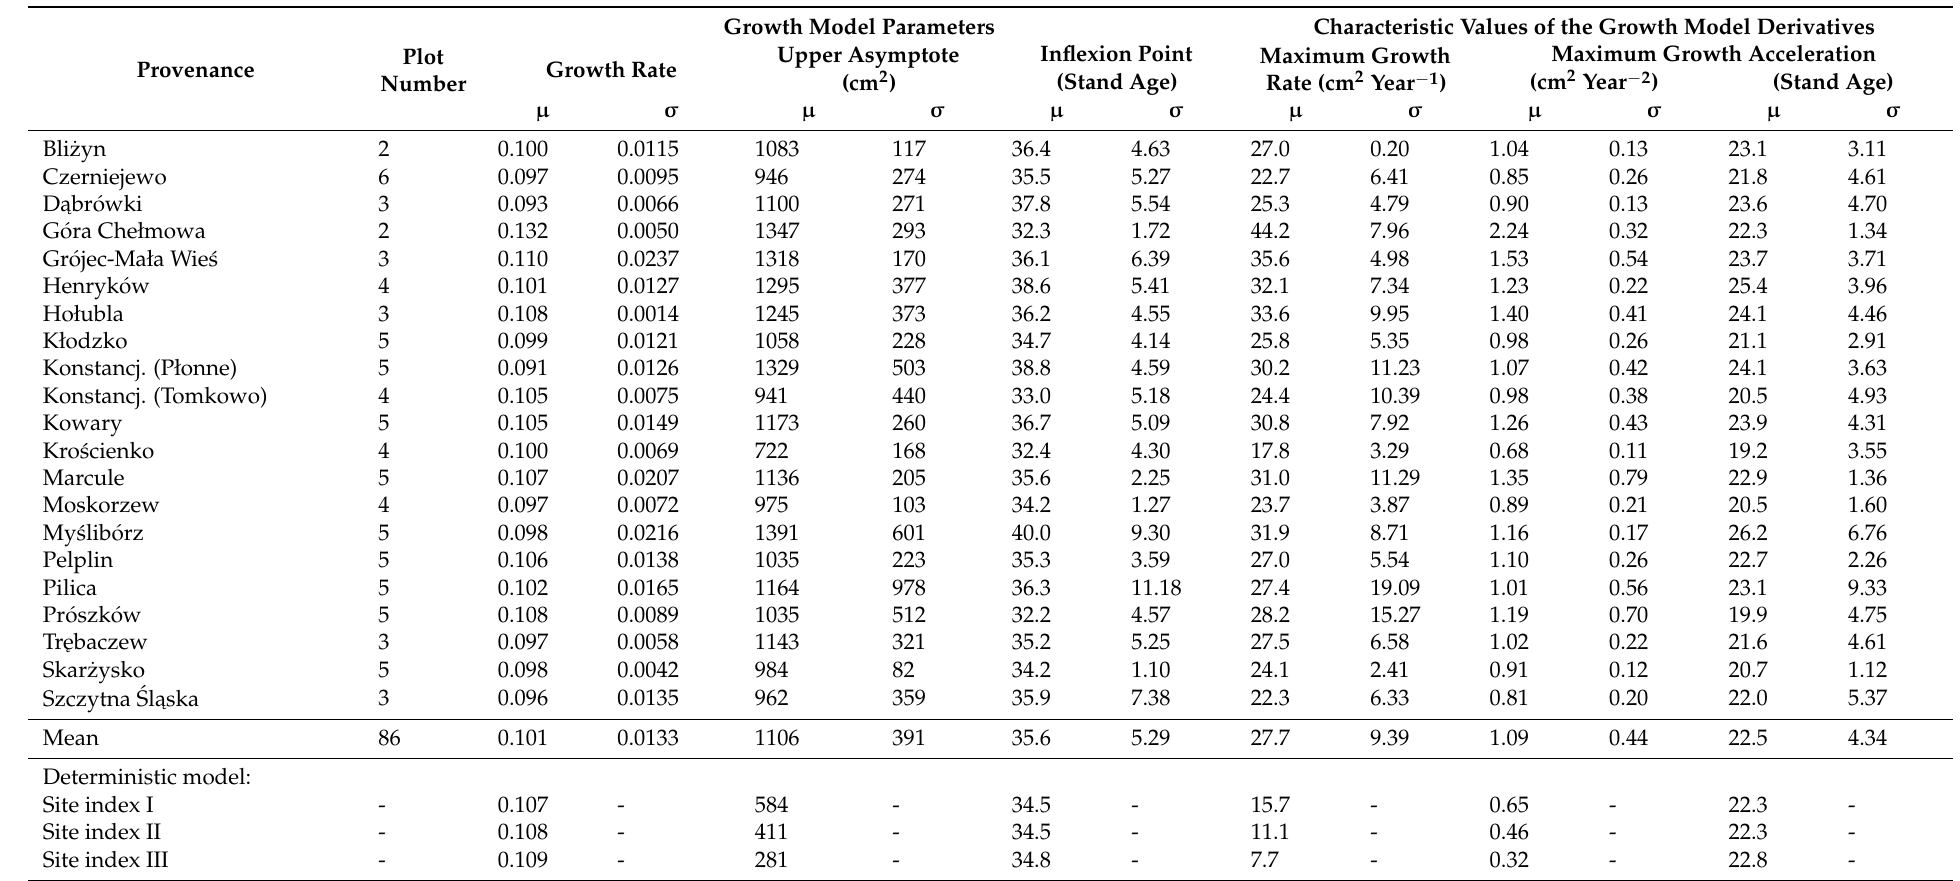
Table 1. Mean ( µ ) and standard deviation ( σ ) of the sigmoid growth model parameters and characteristic points of the first and second derivatives from the larch provenances in the Siemianice forest experimental station and for the Schoberdeterministic model, i.e., the stand volume and yield tables [12,21]—for a corresponding growth period (45 years). Under all provenance rows, the arithmetic mean values for all plots ( n = 86) are